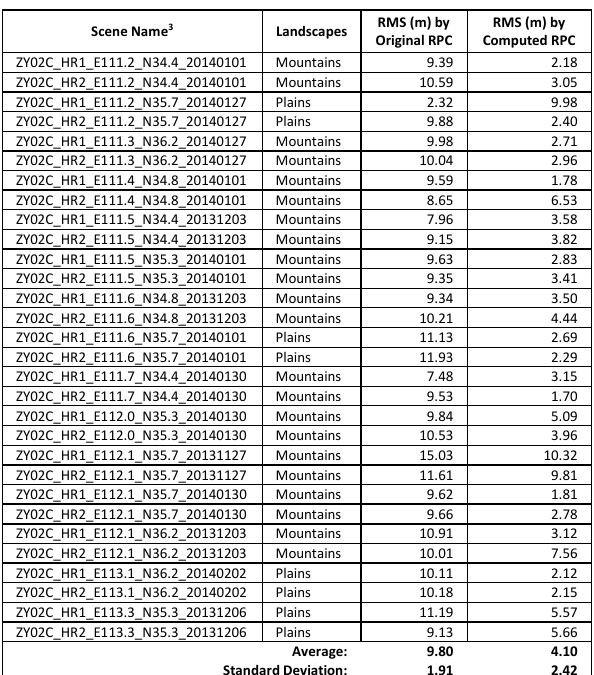
The testing data set consists of 30 scenes (15 pairs of images from left and right cameras) of HRC Level 1 product: 22 scenes with most hilly/mountainous landscapes and 8 scenes with most flat areas. See Table 2 for detailed information of these scenes. These scenes have a nominal 2.36m spatial resolution. Table 2 CBERS-02C testing scenes and accuracy results